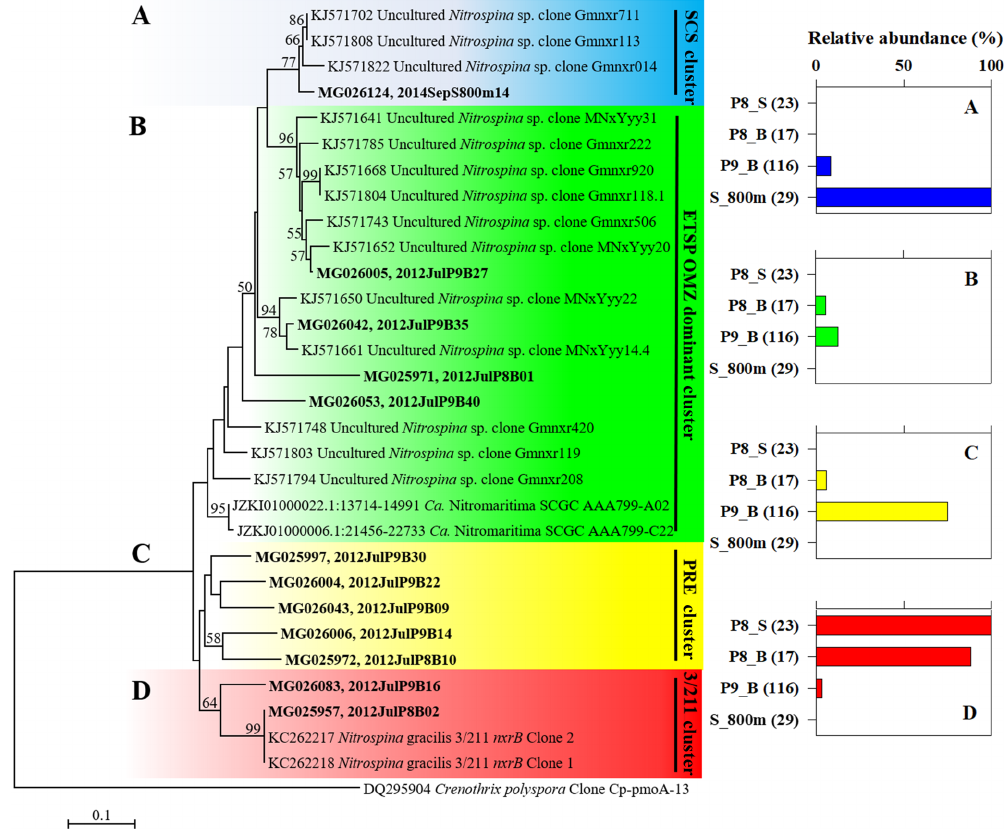
Figure 5. Rooted neighbor-joining (NJ) phylogenetic tree of the Nitrospina nxr B gene sequences. Clone sequences from this study are shown in bold, and sequences sharing 95% DNA identity are grouped. GenBank accession numbers are shown. Groups A, B, C, and D are defined in this study. The relative abundance of clones retrieved for each library in the four subgroups is indicated by a bar. Total number of clones for each library is shown in parentheses. Location of sites P8 and P9 (S and B indicate surface and bottom waters, respectively) and SEATS (S) are shown in Fig. 1. Phylogenetic relationships were bootstrapped 1000 times, and bootstrap values greater than 50% are shown. The scale bar indicates 10% estimated sequence